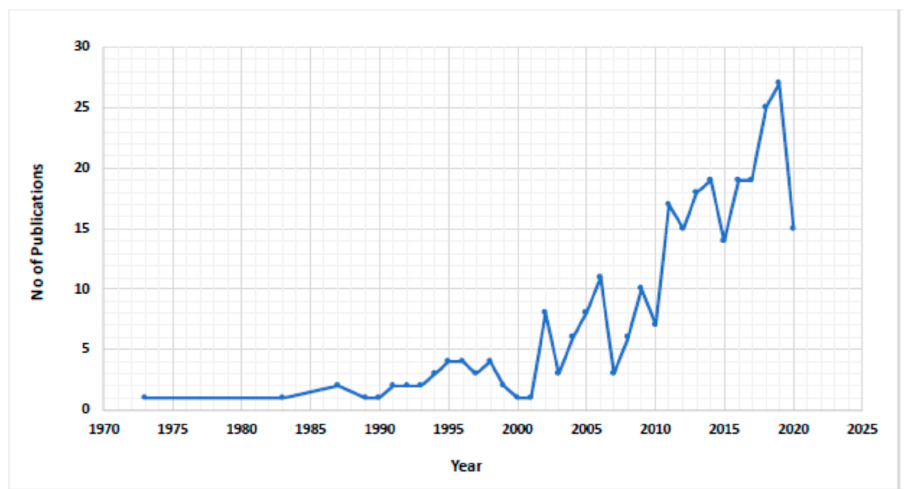
Figure 2. (Search Query: Ginseng in respiratory diseases) The status of publication counts per year Figure 1973.